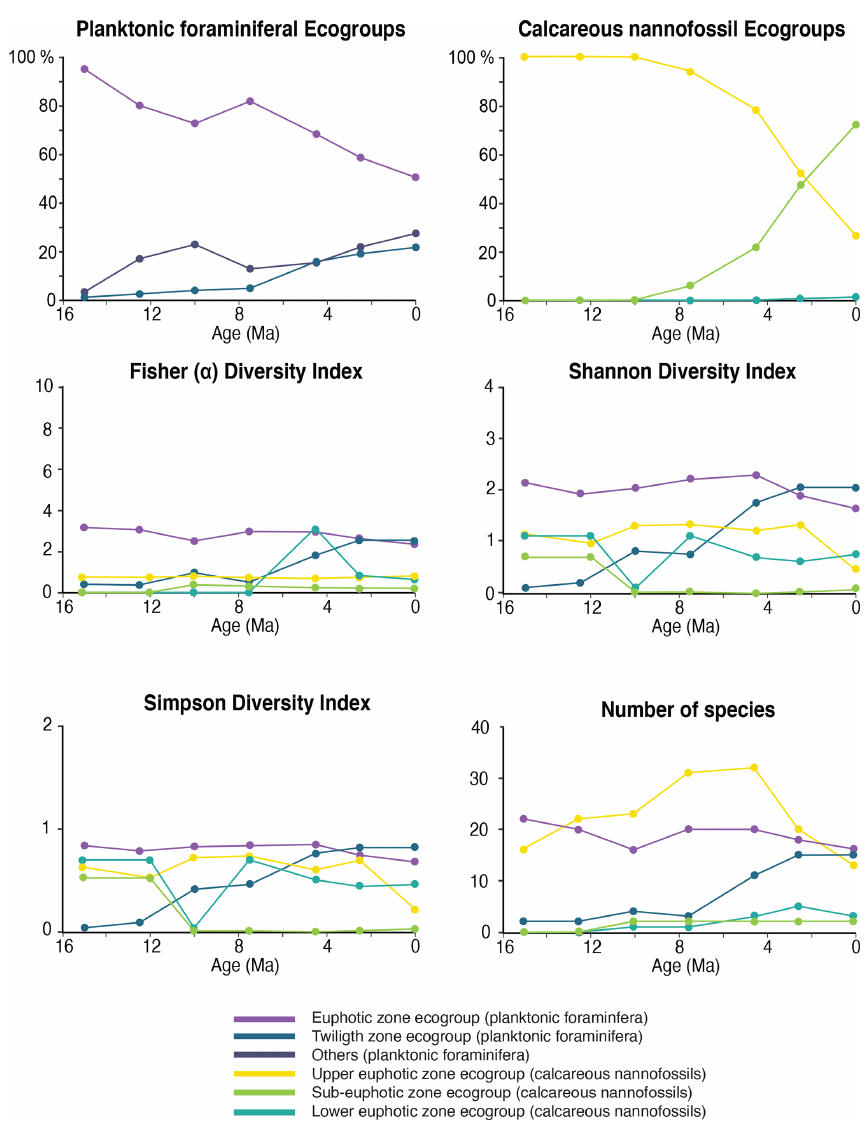
Figure 6. Relative abundance and diversity indexes of planktonic foraminiferal and nannofossil